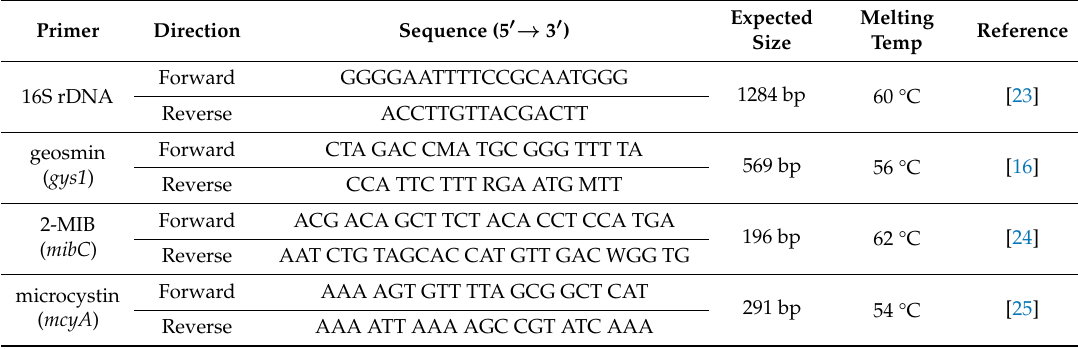
Table 1. Information on the primers used in this